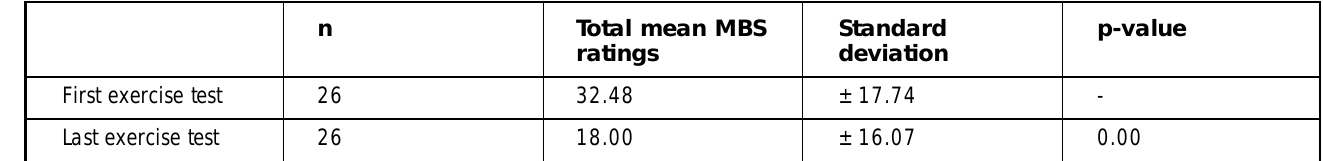
Table 3: Change in total MBS rating over time.